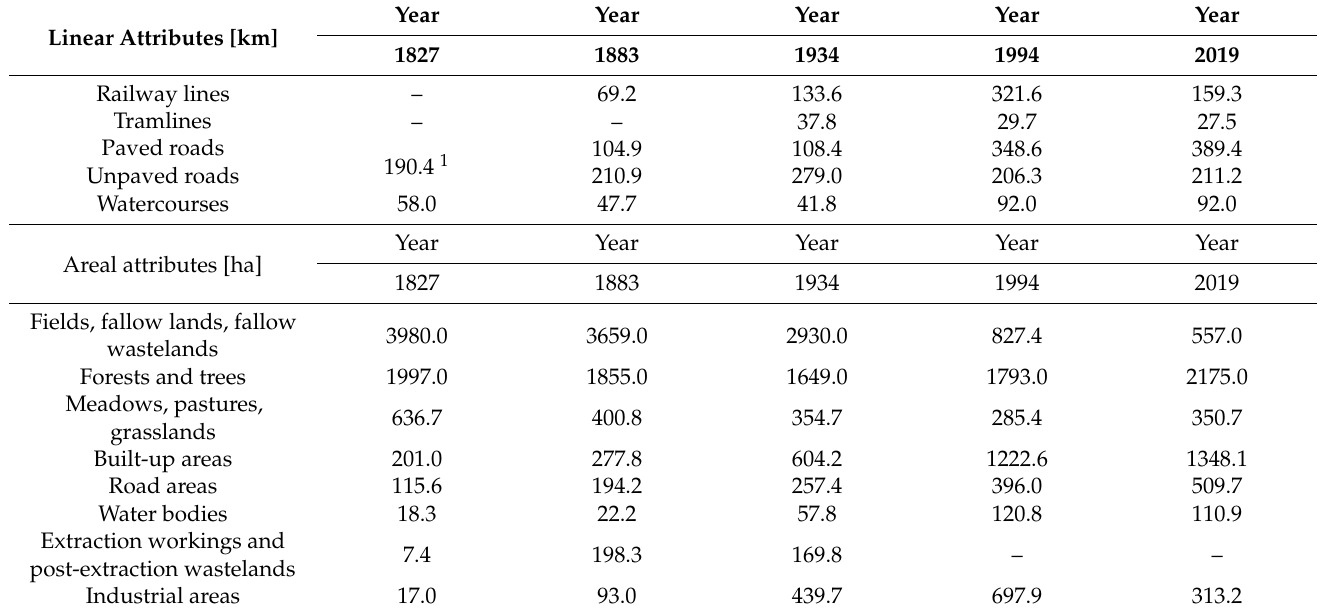
Table 1. Changes in land use in Bytom in the period